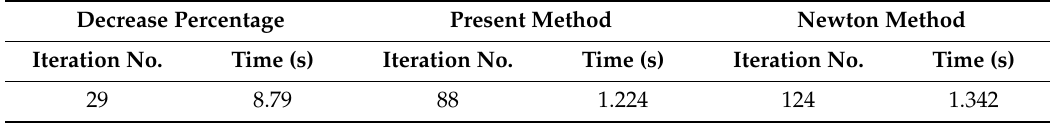
Table 4. Comparison of computational cost and iteration number